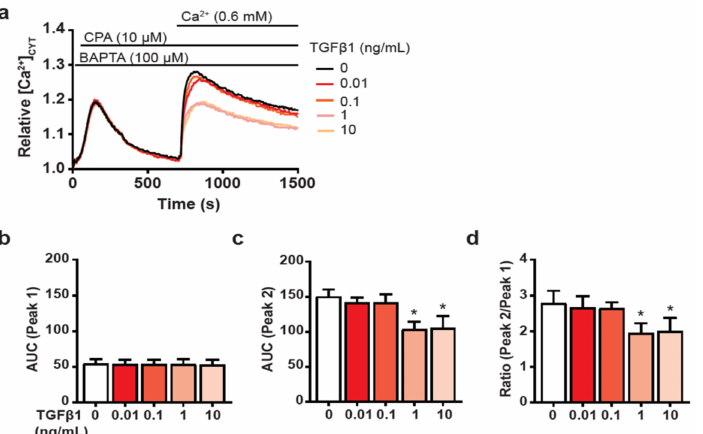
Figure 2. Assessment of cytosolic Ca 2+ levels during the store-operated calcium entry (SOCE) response in TGF β 1-treated HMF3S cells. ( a ) Serum starved HMF3S cells were treated with TGF β 1 (0.01, 0.1, 1, or 10 ng/mL) or vehicle control (0 ng/mL) for 48 h prior to imaging. To assess potential remodelling of SOCE, cells were sequentially treated with 1,2-bis(o-aminophenoxy)ethane-N,N,N (cid:48) ,N (cid:48) - tetraacetic acid (BAPTA, 100 µ M) to chelate extracellular Ca 2+ , cyclopiazonic acid (CPA, 10 µ M) to deplete intracellular Ca 2+ stores, and Ca 2+ (0.6 mM) to assess store-operated calcium influx. Calcium traces represent relative cytosolic calcium levels ([Ca 2+ ] CYT ) as mean fluorescence relative to baseline. Quantitation of ( b ) area under the curve (AUC; peak 1), ( c ) AUC (peak 2), and ( d ) ratio AUC (peak 2/peak 1). In ( b – d ) data are represented as mean ± SD from three independent experiments. * p < 0.05 from post-hoc Dunnett’s multiple comparison test after one-way ANOVA revealed significant effect of